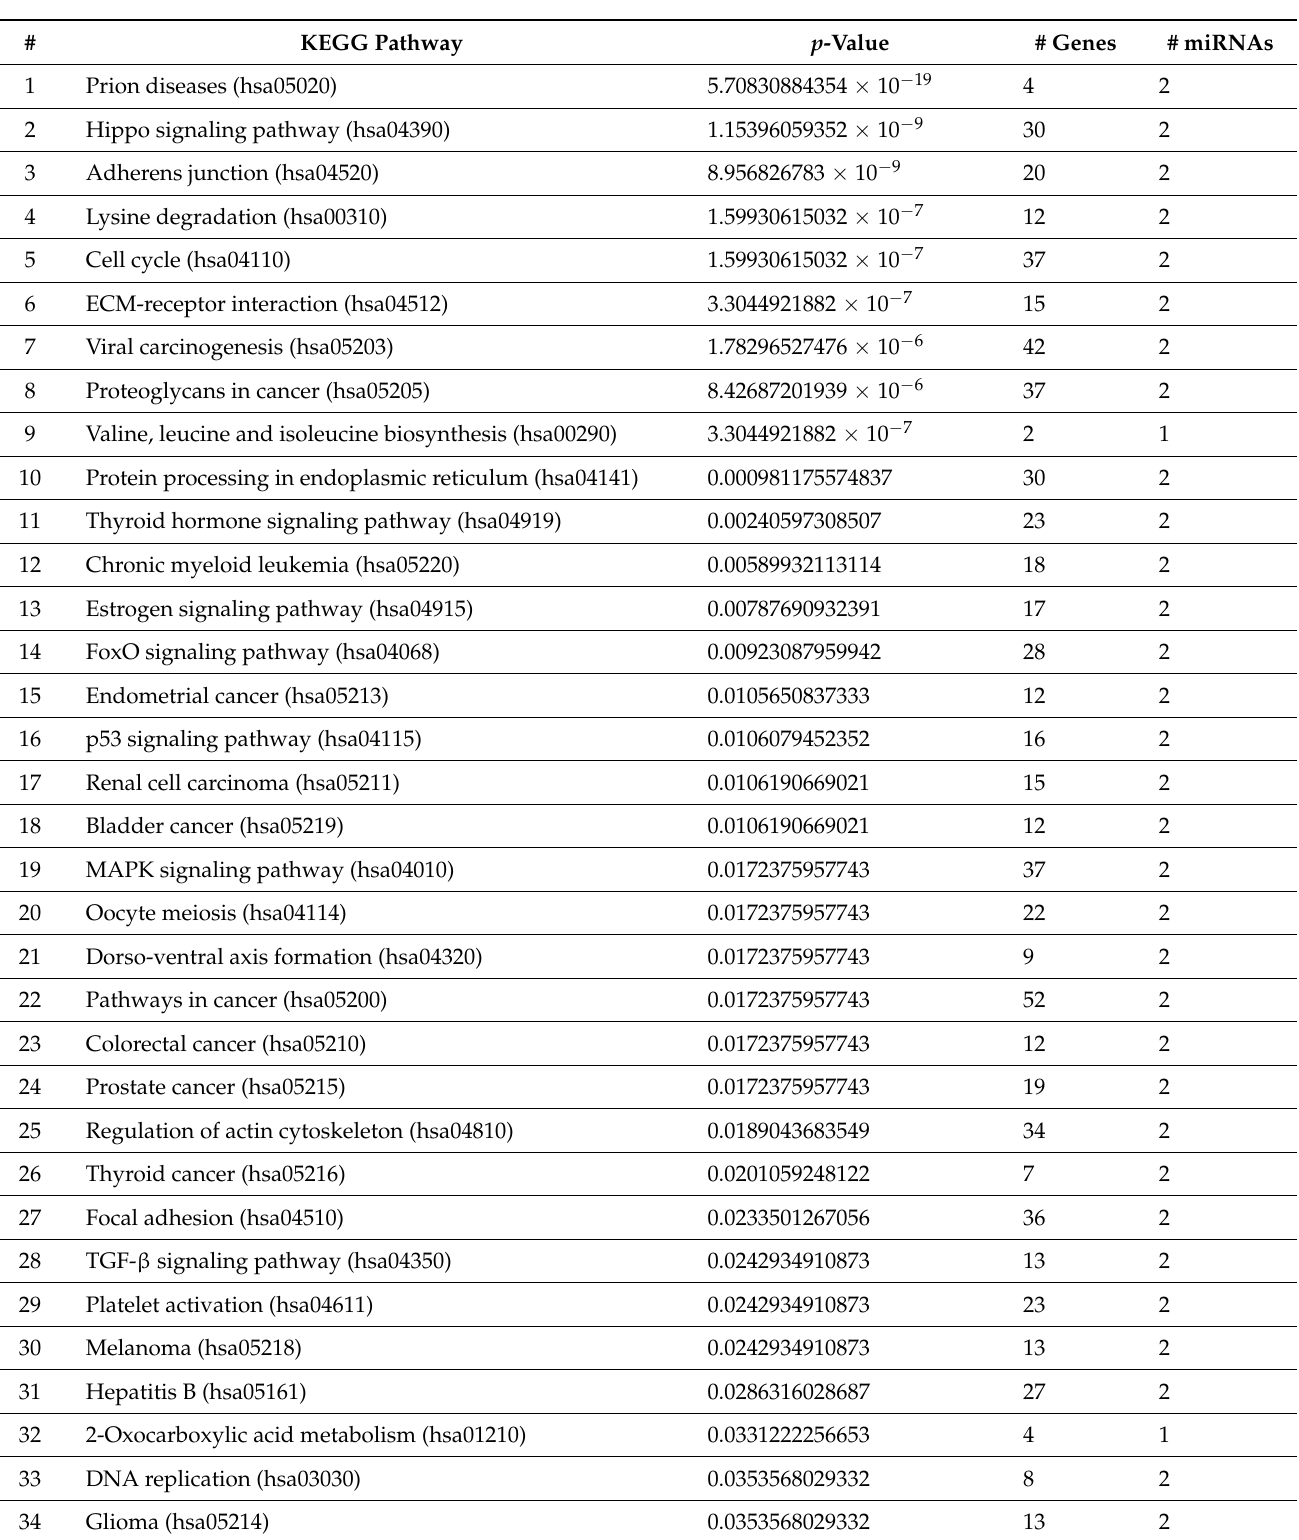
Table 3. Pathway analysis showing the biological processes in which the investigated miRNAs are involved. This table show the pathway affected by hsa-miR-25-3p and hsa-miR-185-5p, the measure of the significance ( p -value column), the number of the regulated genes belonging to the pathway (# genes column) and if both the miRNAs are implicated in the modulation of the pathway or not (# miRNAs